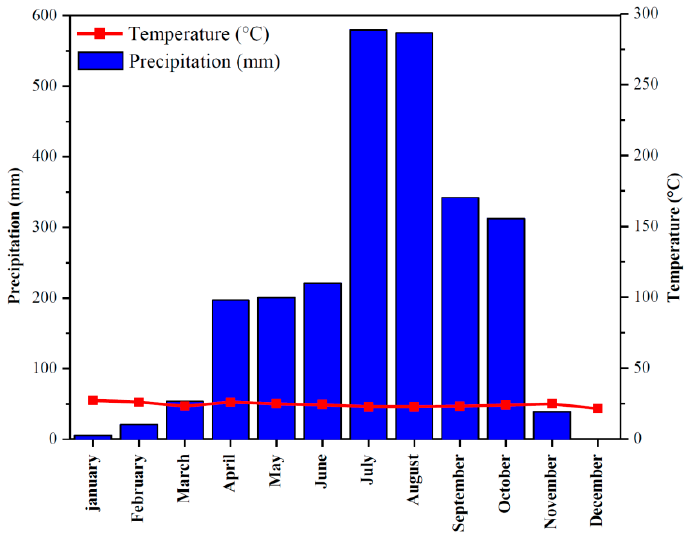
Figure 2. Average annual rainfall and temperature distribution for Bamenda. Source: Northwest regional service for meteorology. These average monthly precipitation / temperature data were recorded between 2005–2010.